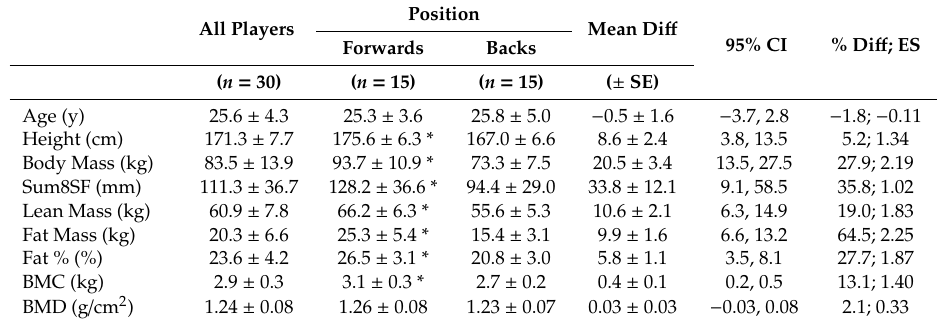
Table 1. Demographics, anthropometrics and total body composition characteristics of elite female rugby union (RU) players.